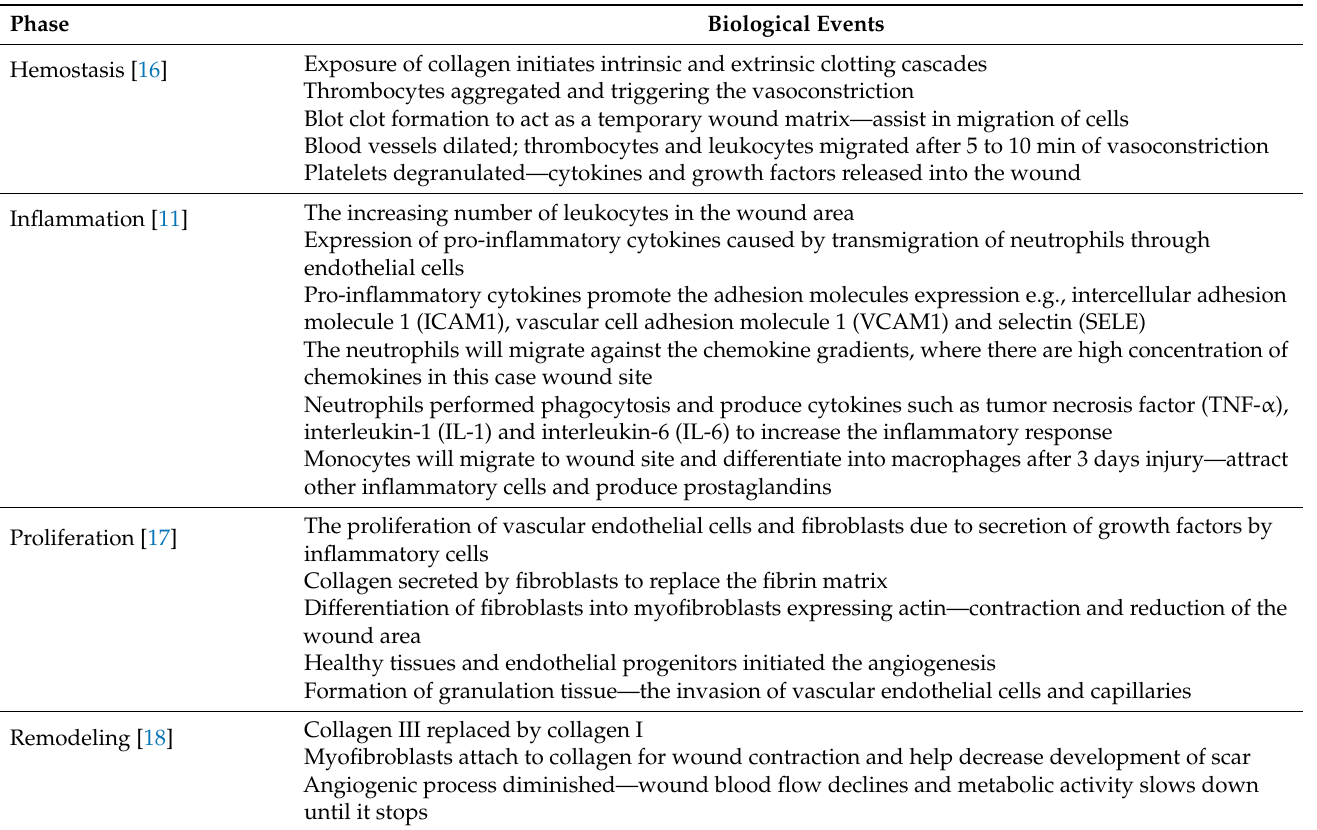
Table 1. Wound healing